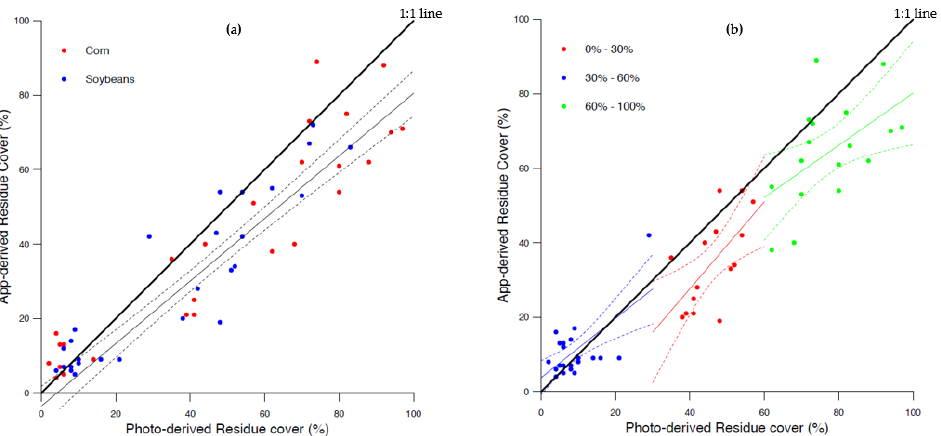
Figure 3. Relationships between residue cover percent as determined by photograph-grid and app: ( a ) residue cover (corn = red dots and soybean = blue dots); and ( b ) residue levels (Low = blue, medium= red and high = green). Related statistics are shown in Table 2.